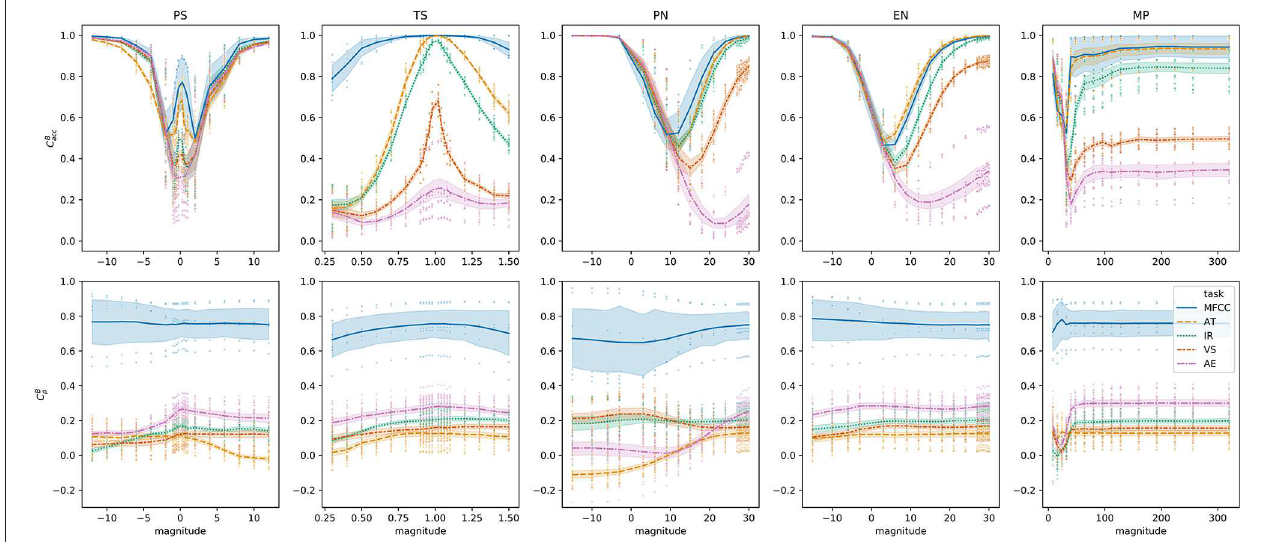
FIGURE 10 | C B acc (top) and C B ρ (bottom) between-space consistency by transformation and magnitude. Each curve indicates the between-space consistency C B with respect to the task. Confidence intervals are drawn at the 95% level. Points indicate individual observations from different trials.